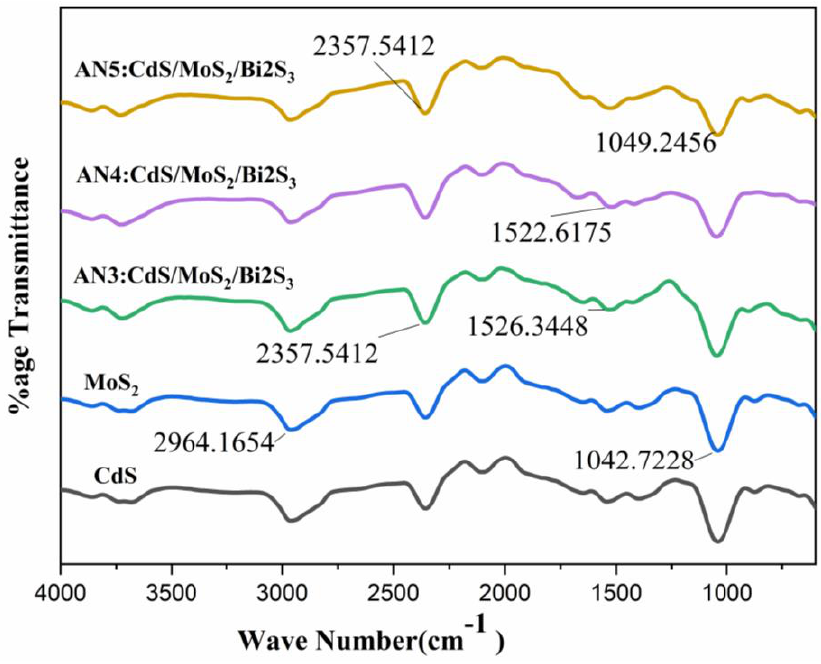
Figure 2. FTIR spectra of CdS, MoS 2 , (AN3)CdS/MoS 2 /Bi 2 S 3 composite (1%/1%/1%), (AN 4 )CdS/MoS 2 /Bi 2 S 3 composite (1%/5%/5%), and (AN5)CdS/MoS2/Bi 2 S 3 composite (2%/5%/5%).